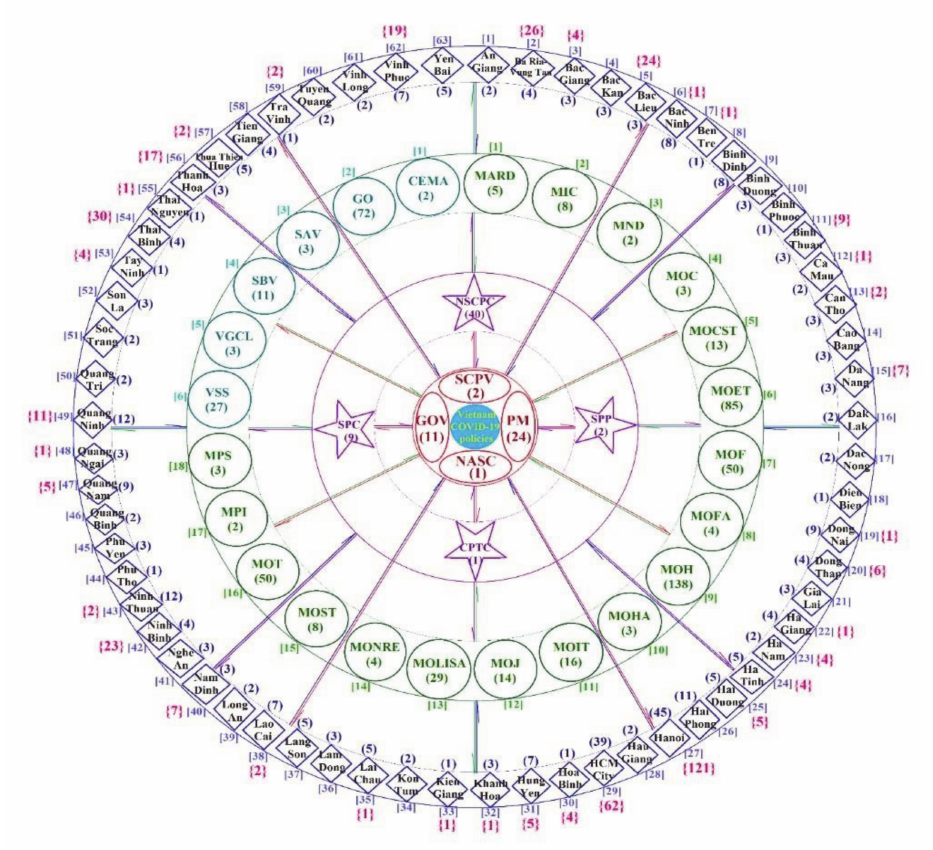
Figure 3. The map of nationwide policy responses to COVID-19 in Vietnam (as of 24 July 2020). (Notes: The number of PDs are in ( ) and the number of CCs of each province are in { }; ordinal number of units due to the alphabet from A–Z at the same level are in [